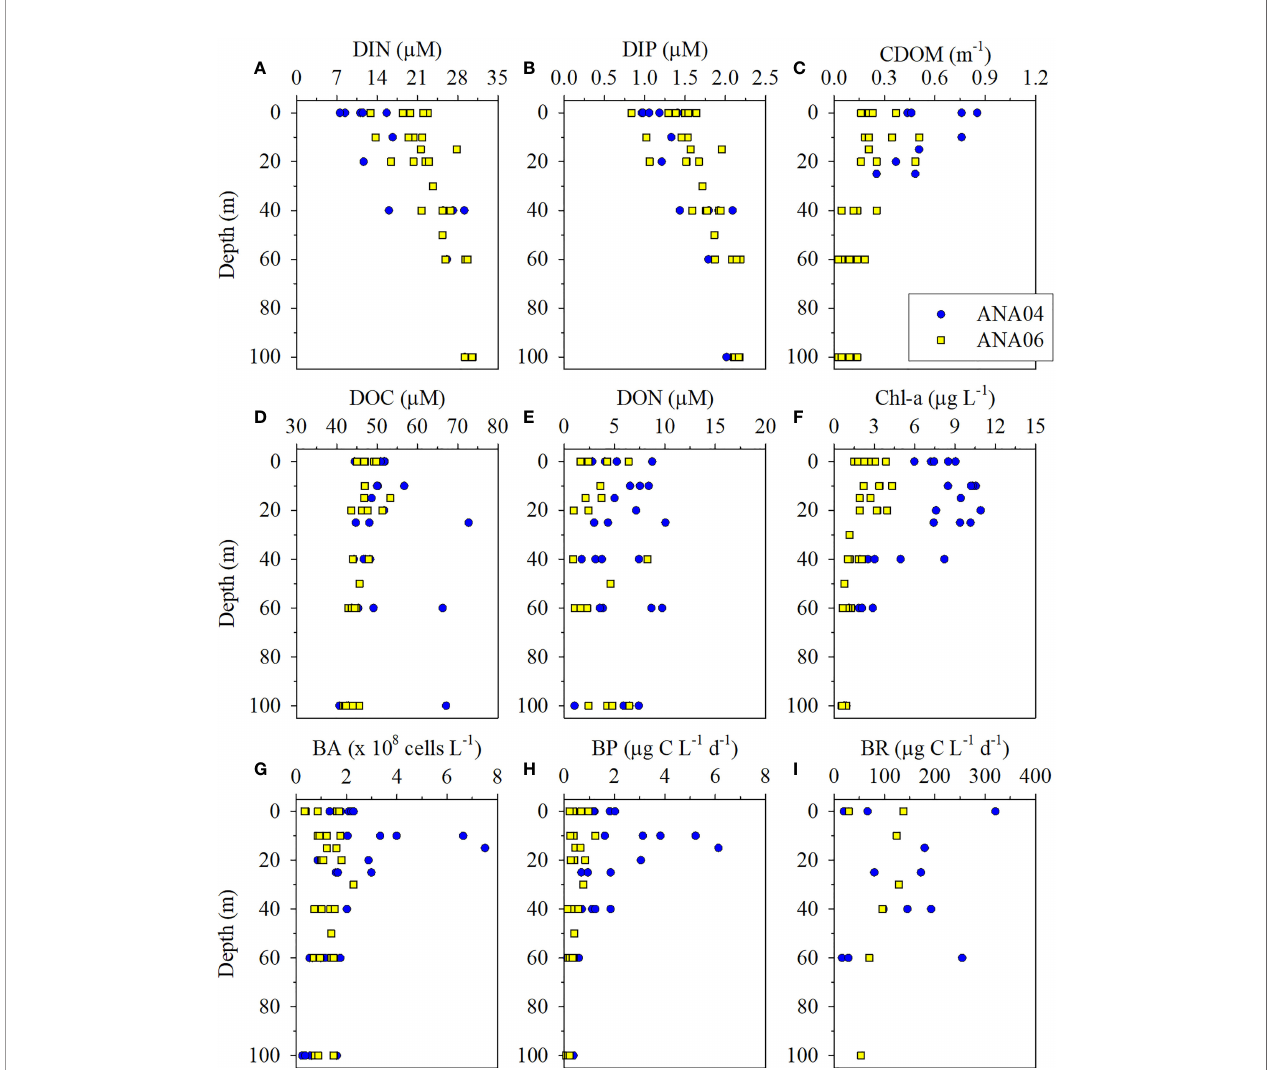
FIGURE 2 | Depth pro fi le of chemical and biological parameters during ANA04 and ANA06. Dissolved inorganic nitrogen (DIN) (A) , dissolved inorganic phosphate (DIP) (B) , chromophoric dissolved organic matter (CDOM) (C) , dissolved organic carbon (DOC) (D) , dissolved organic nitrogen (DON) (E) , chlorophyll-a (Chl-a) (F) , bacterial abundance (BA) (G) , bacterial production (BP) (H) , and bacterial respiration (BR) (I)